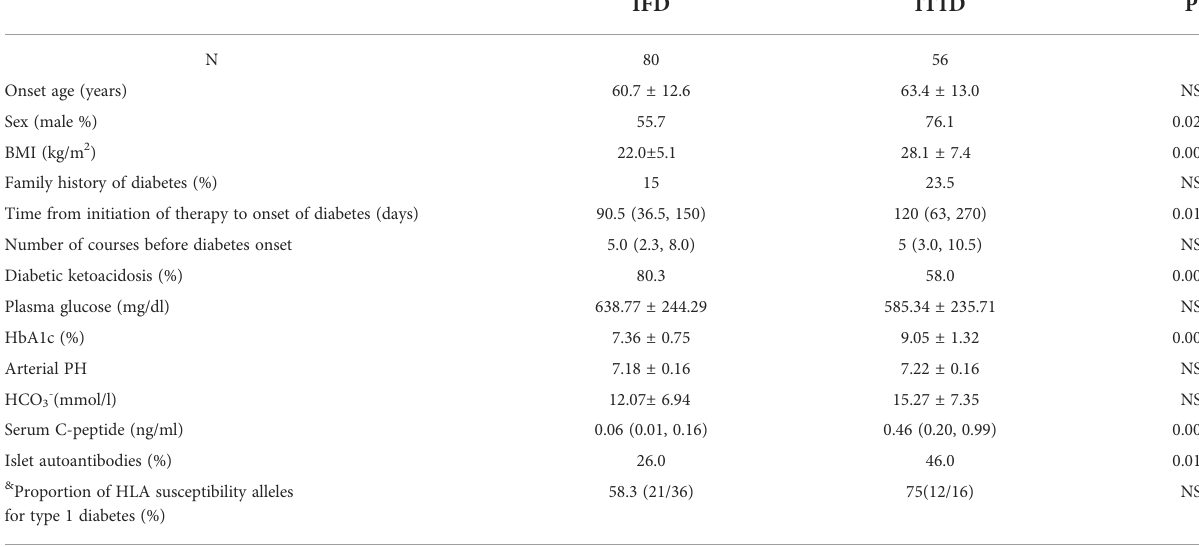
TABLE 1 The clinical and biological characteristics of different ICI-associated